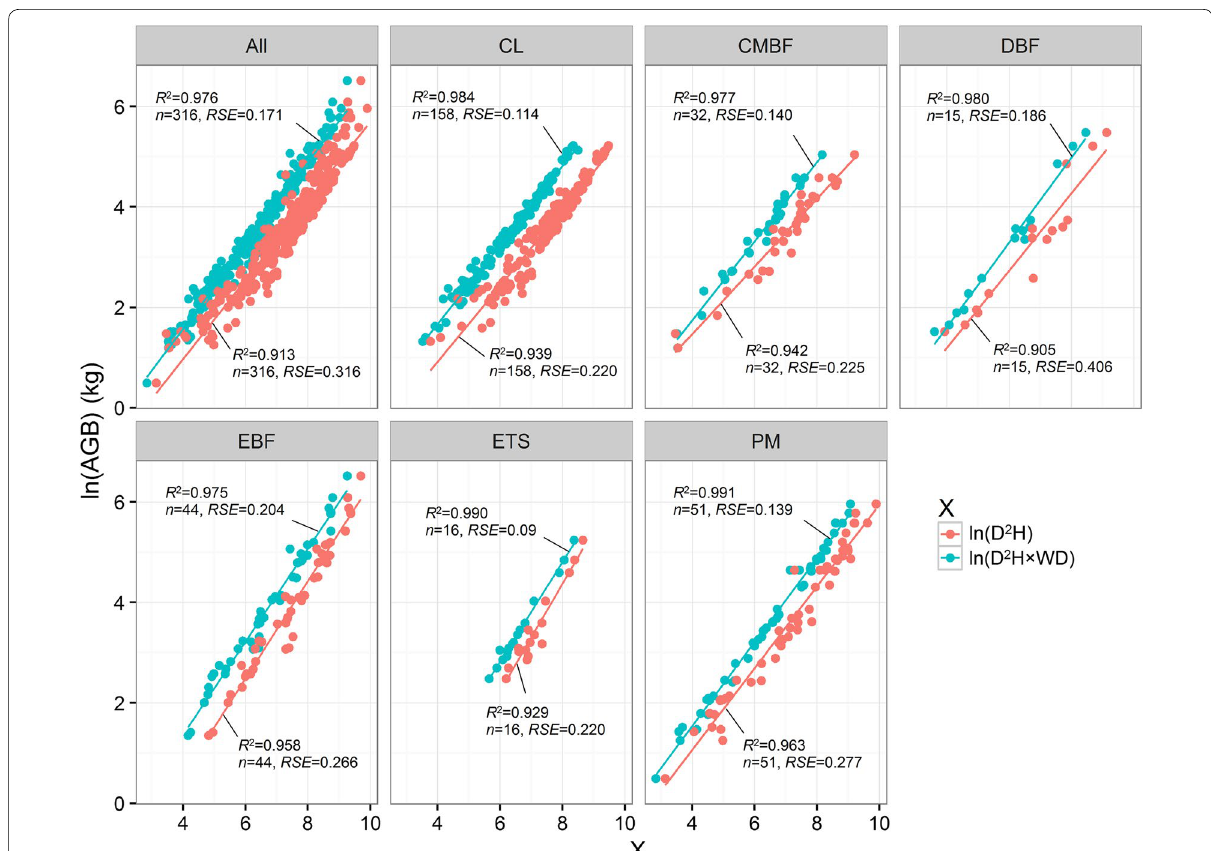
Fig. 3 Fitted curves for each forest type and all forest types at regional scale in subtropical region of China applied the allometric model with wood density variable, and the allometric model without wood density variable. See Table 1 for the abbreviations of the six forest